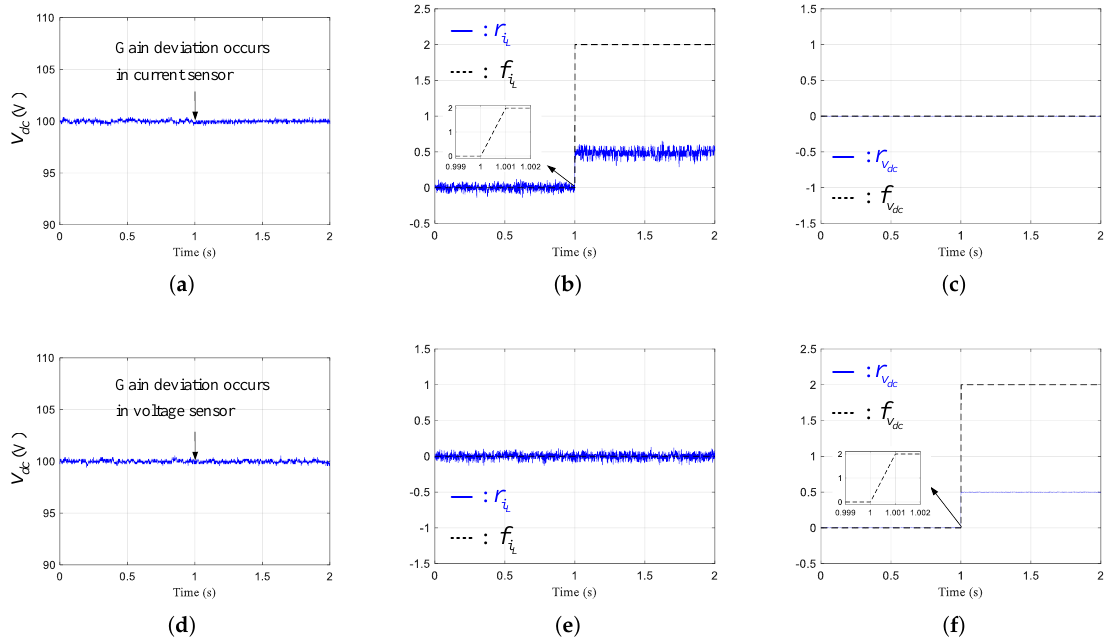
Figure 7. Output voltage, normalized residuals and fault flags of the proposed observer under a gain deviation condition in the current sensor ( a – c ) and voltage sensor ( d – f